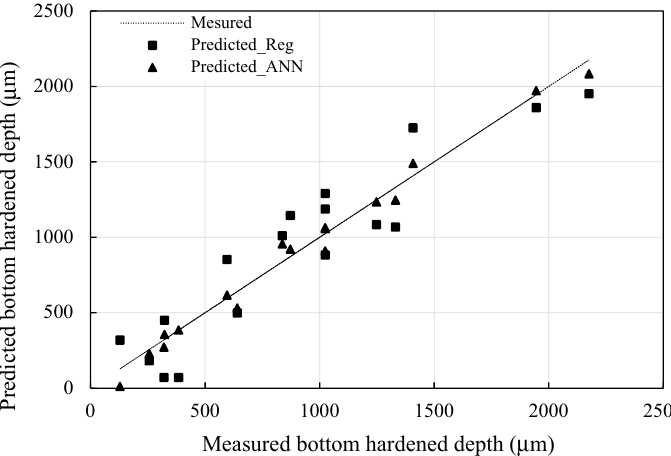
Figure 15. Measured and predicted tooth bottom hardened depth.